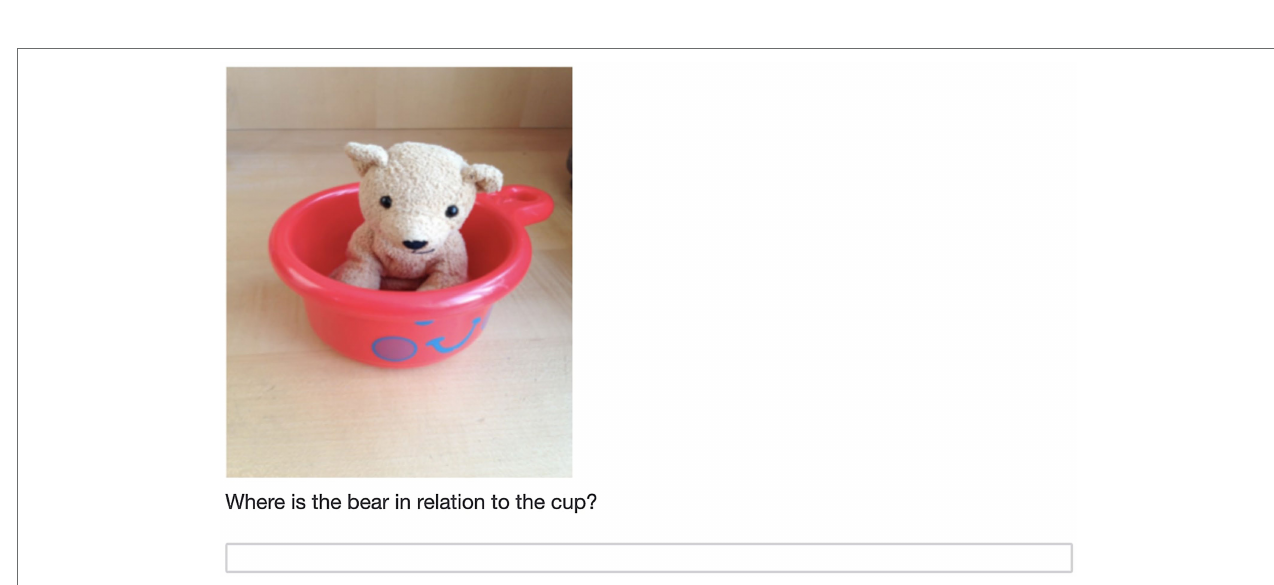
FIGURE 6 | Example trial from the expressive spatial relation portion of the spatial vocabulary